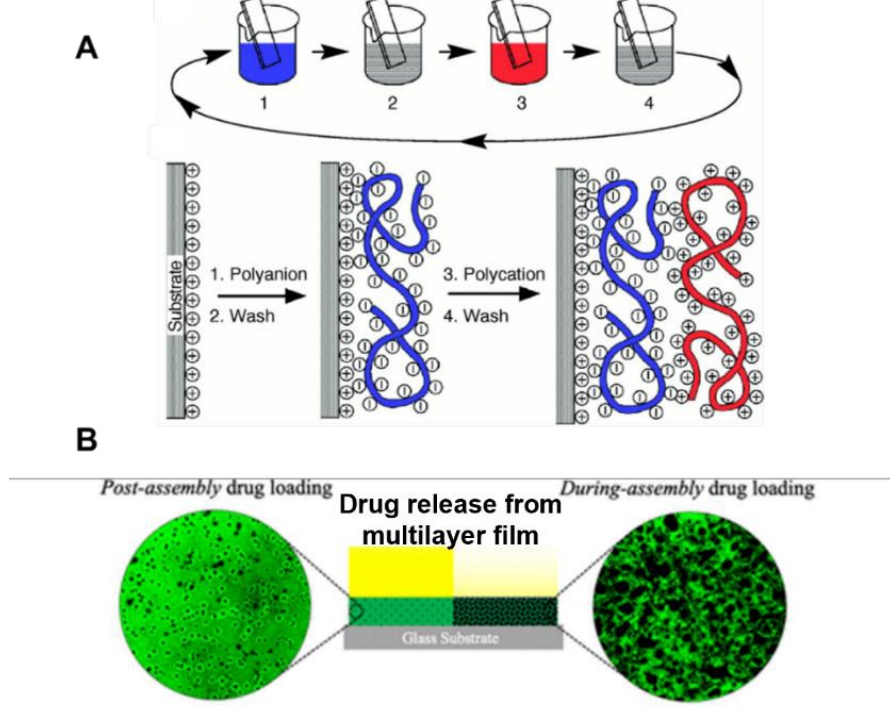
Figure 3. LbL film buildup. ( A ) Depiction of the layer-by-layer film assembly strategy applied to polyelectrolytes. Sequential adsorption of oppositely charged species on a substrate enables the fine control of the film thickness and composition. ( B ) The resulting surface coatings containing weak polyelectrolytes can embed drugs either during or post-assembly through non-covalent interactions. Figures ( A ) [16] and ( B ) [95] are reproduced with permission from the original articles.